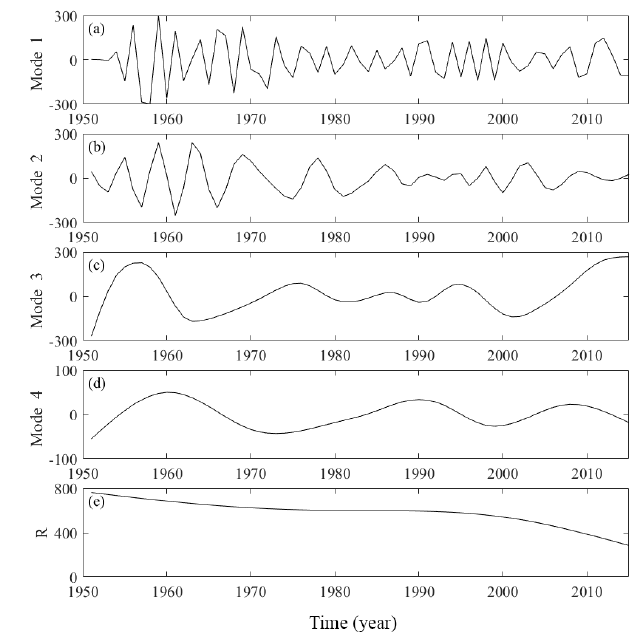
Figure 3. Modal components and trend of precipitation time series by ESMD